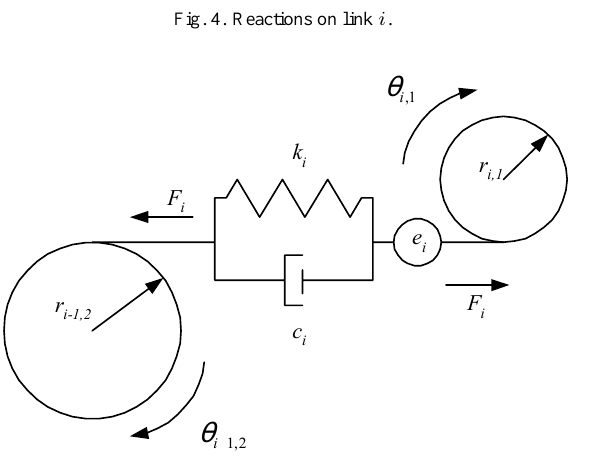
Fig. 4. Reactions on link i .